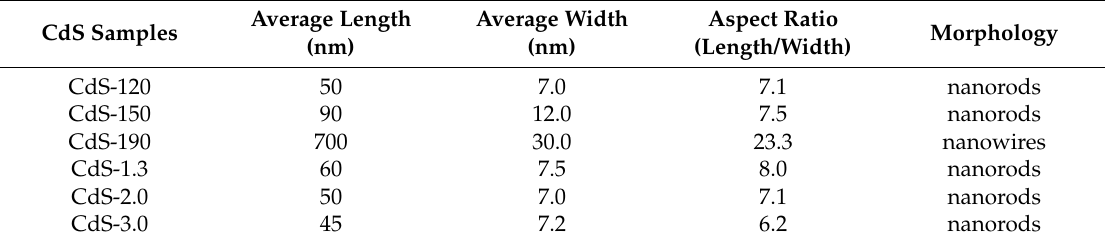
Table 4. Morphological characteristics of CdS samples derived from TEM-HRTEM analysis.